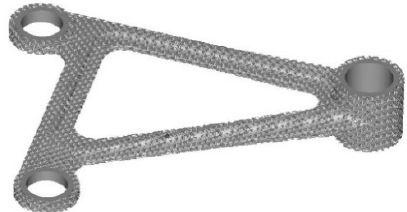
( b ) Figure 14. The rocker arm is loaded by force: ( a ) Load the force along the positive X axis; ( b ) Load the force in the negative Y direction. Figure 15. Stress nephogram of rocker arm (Pore 1). The maximum compressive strength of porous Ti6Al4V alloy with boron content of 0 wt% and 0.025 wt% is 292.27 MPa and 365.50 MPa, respectively, which cannot meet the requirements of mechanical properties. Therefore, in order to meet the mechanical prop- erties, the amount of boron should be 0.05 wt%. After calculation, only when the diameter of the rod is 200 μ m and the number of internal rods is 12, its compressive strength is 416.47 mpa, which can meet the strength requirements. Import Inspire software to retain